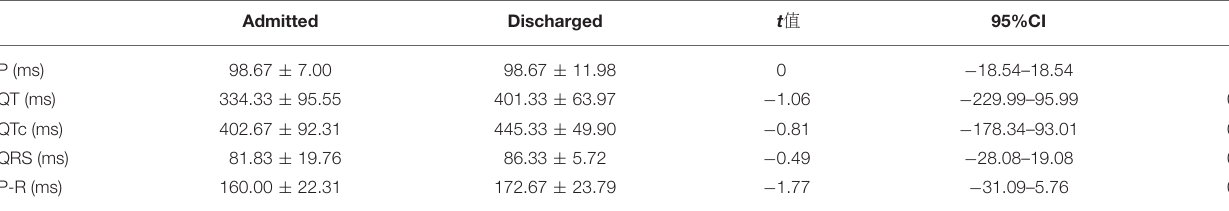
TABLE 5 | Comparison of P, QT, QTC, QRS, and P-R intervals in ECG of 6 patients before and after